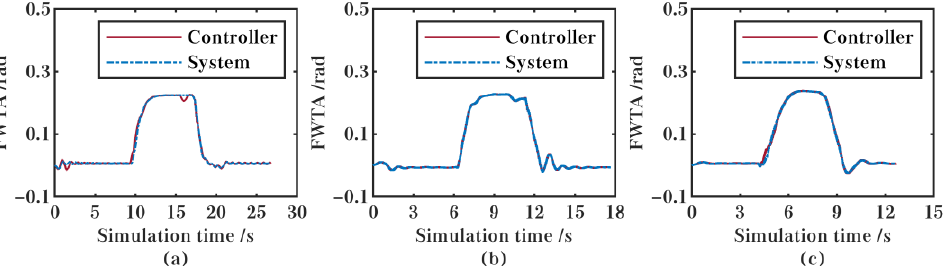
Figure 11. The front wheel turning angle of the simulation at different speeds: ( a ) at 2 m/s; ( b ) at 3 m/s; ( c ) at 4 m/s.